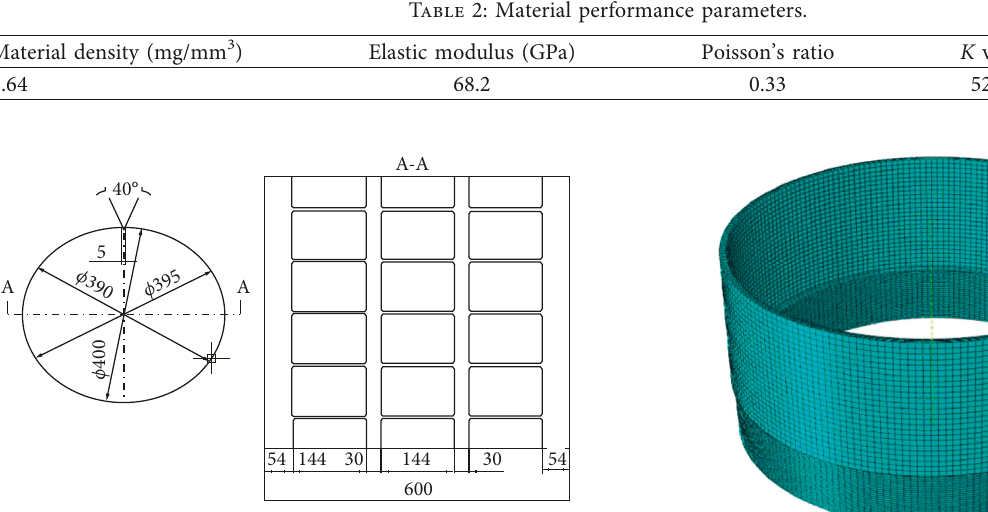
Figure 5: Blank meshing.